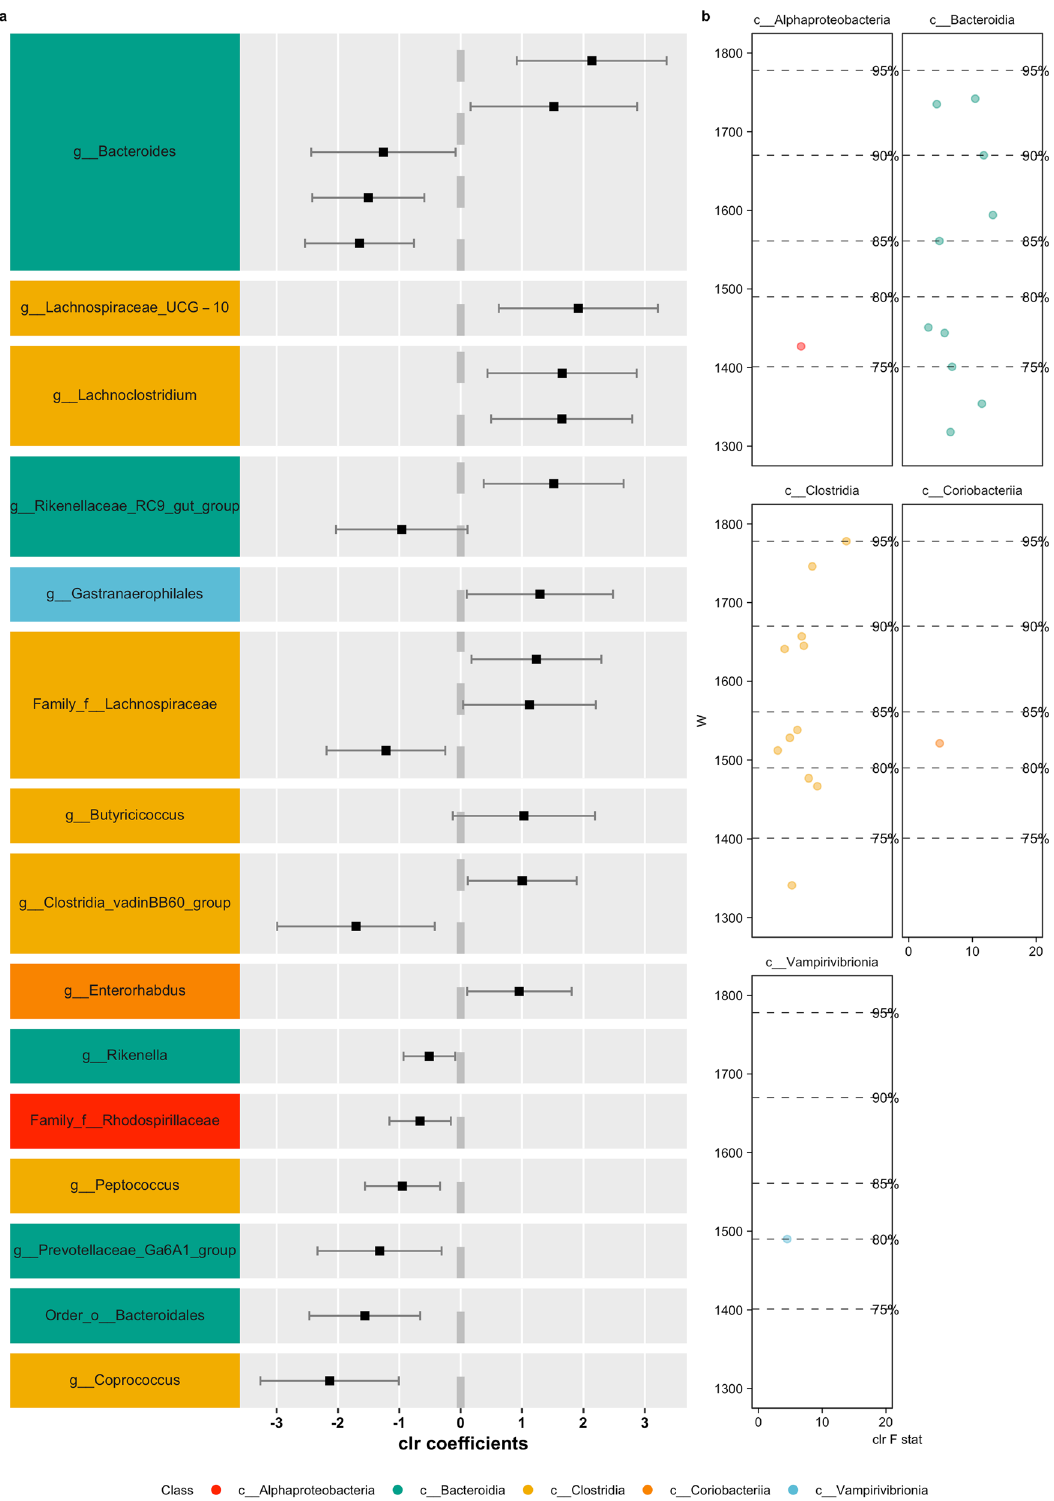
Fig. 6 Differentially abundant ASVs (using ANCOM) in pairwise comparisons with landscape groupings based on similar responses in beta diversity to landscape modifications (Fig. 4) in P. opossum comparing landscape C against A P. Colors represent the different bacterial classes. a Differential + abundant ASVs according to the taxonomical assignment; b Volcano plot of differential abundant ASVs, depicting the F statistics and